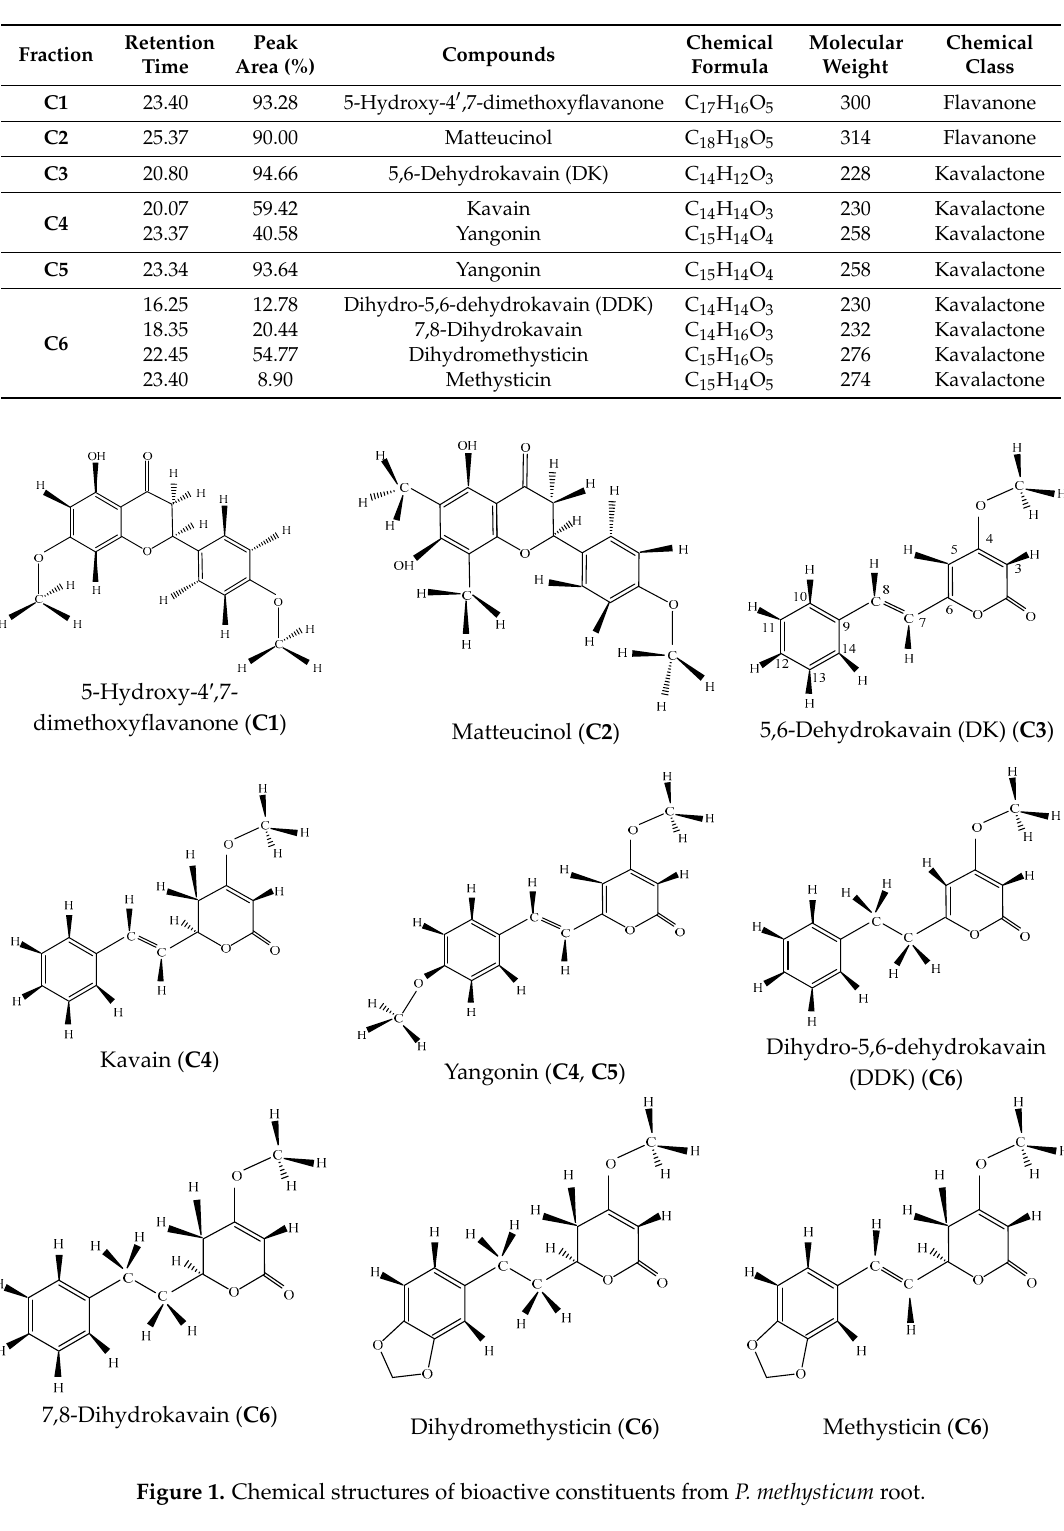
Table 4. Identification of bioactive compounds from EtOAc extract of P. methysticum root by GC-MS, ESI-MS and 1 H- and 13 C-NMR.